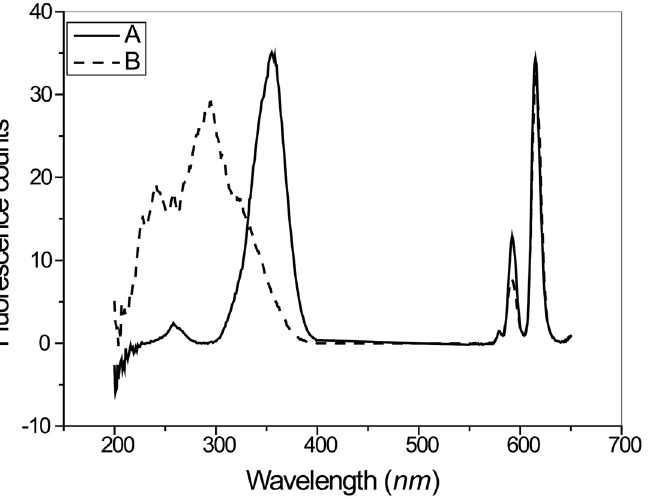
Fig 9. Excitation and Emission spectra of BC-EDTA/Eu 3+ (A) and BC-EDTA/Eu 3+ -nanosphere (B). (A) The concentration of BC-EDTA/Eu 3+ is 10 -3 mol/L. The buffer was 0.05 mol/L carbonate buffer, pH9.5. (B) The concentration of BC-EDTA/Eu 3+ -nanosphere is 0.005%. The buffer was 0.05 mol/L carbonate buffer, pH9.5.